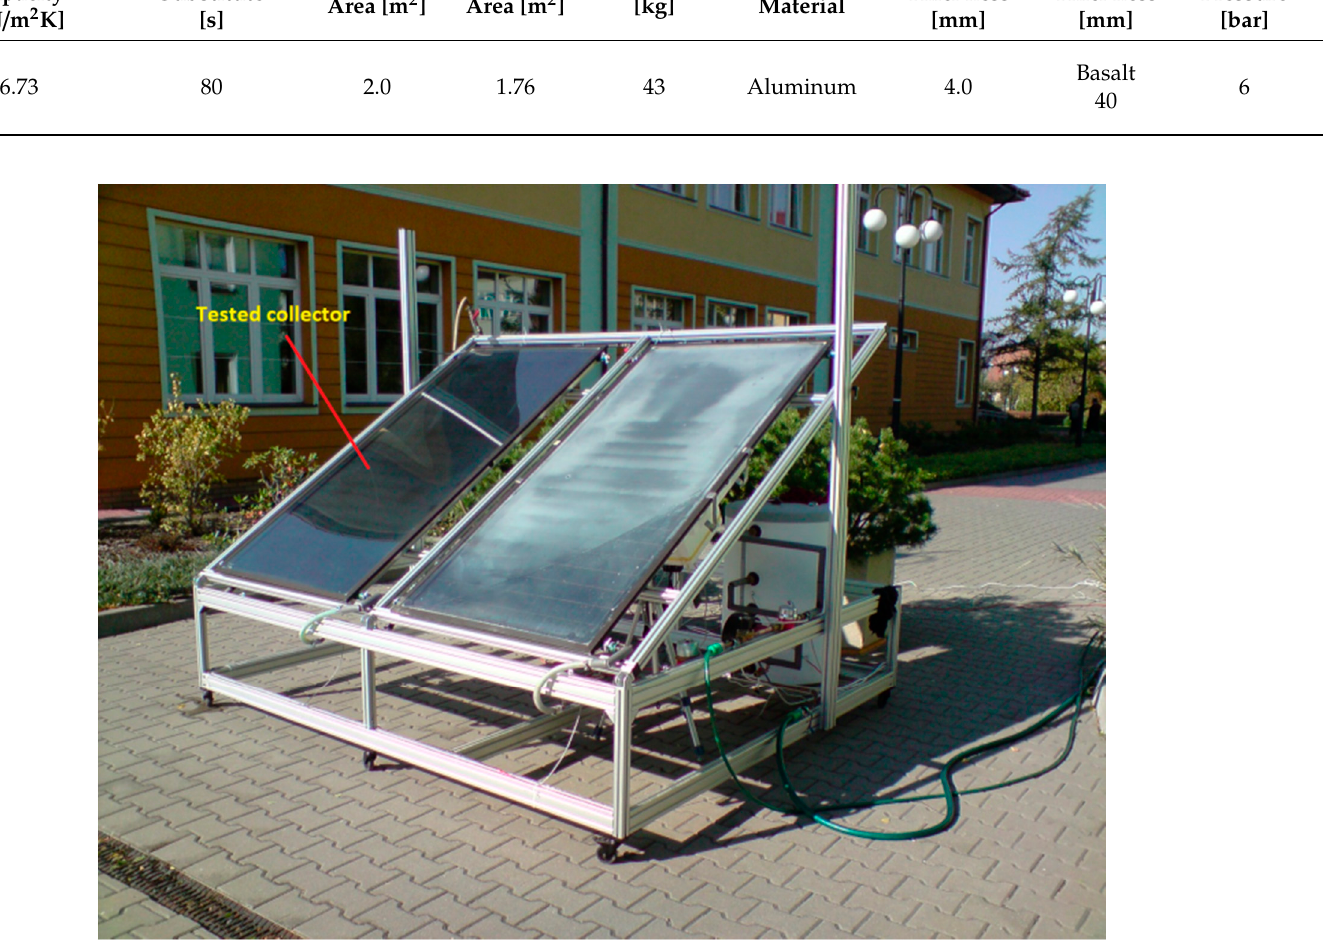
Figure 4. Visualization of work of test stand I in the Supervisory Control and Data Acquisition (SCADA) system.